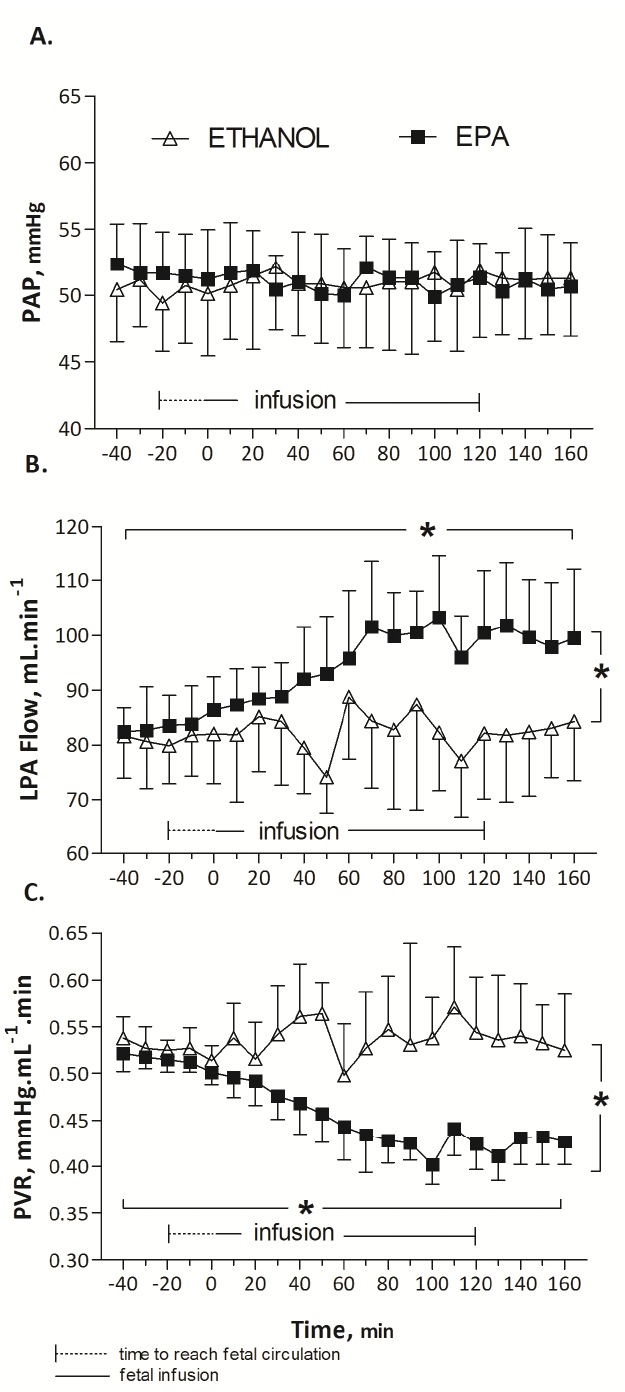
Figure 2. Evolution of pulmonary artery pressure, PAP ( A ), left pulmonary artery blood flow, LPA flow ( B ) and pulmonary vascular resistance, PVR ( C ) in response to infusion of EPA compared to infusion of ethanol (in vivo experiment). EPA or ethanol was infused from T-20 to T120. The LPA flow was greater ( B ) and PVR lower ( C ) during EPA than during ethanol infusion. Results are expressed as means ± SEMs, n = 8 (EPA) or 6 (control). * p < 0.001 comparing EPA vs. ethanol groups (Two-way ANOVA) and comparing baseline vs. EPA infusion (one-way ANOVA).